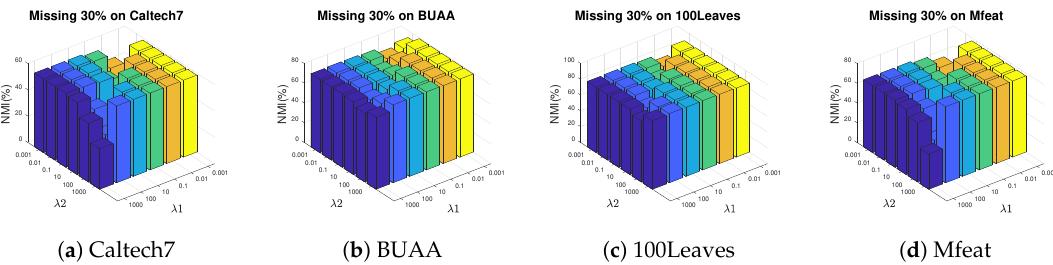
Figure 5. The influence of parameters λ 1 and λ 2 on NMI when 30% instances are missing on four